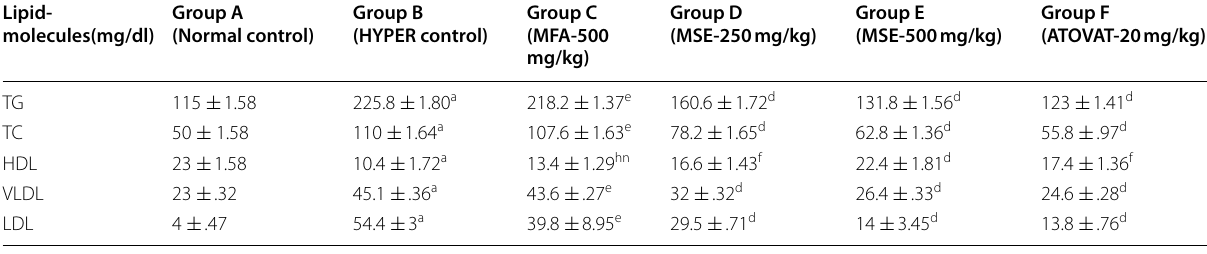
Table 2 The antihyperlipidemic potentiality of MM plant extracts at different conc. in HCD mice Lipid‑ Group A molecules(mg/dl) (Normal control)